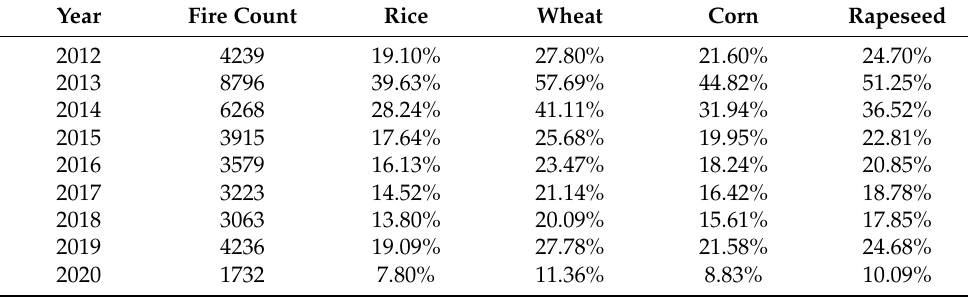
Table 3. The proportion of crop residue open burning after being